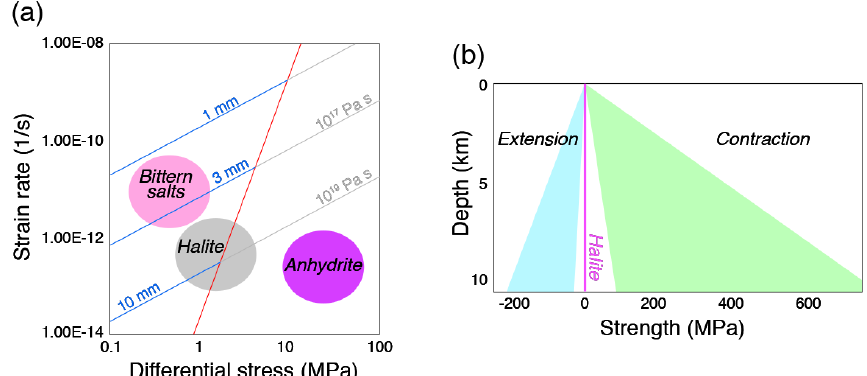
Figure 3. (a) Stress–strain rate diagram at a temperature of 60 ◦ C illustrating the most likely conditions for evaporite deformation addressed in this paper. The grey lines represent different halite viscosities, the red line is an extrapolation of laboratory data for dislocation creep of halite, and the blue lines are the flow lines for pressure–solution creep for different grain sizes. The intersections of the blue lines with the red line represent steady-state flow where the grain size is in equilibrium with the differential stress. Thus, the grey ellipse is an estimate of the stress and strain rate conditions for the flow of halite in the subsurface, constrained by measurement of the differential stress by subgrain-size piezometry. The purple ellipse is an estimate of the conditions for anhydrite deformation during layer-parallel shortening based on analysis of fold shapes, and the pink ellipse is an estimate of the condition for bittern salts. (b) Schematic diagram comparing the strength of halite and non-evaporite rocks as a function of depth in extension and contraction (adopted from Weijermars et al., 1993, and Jackson and Hudec, 2017). The purple line is for wet halite, which has a constant, very low strength (<1MPa); the colored fields are for non-evaporite rocks in extension (blue) and contraction (green), which range from dolostones (very strong) to highly overpressured mudstones (very weak).